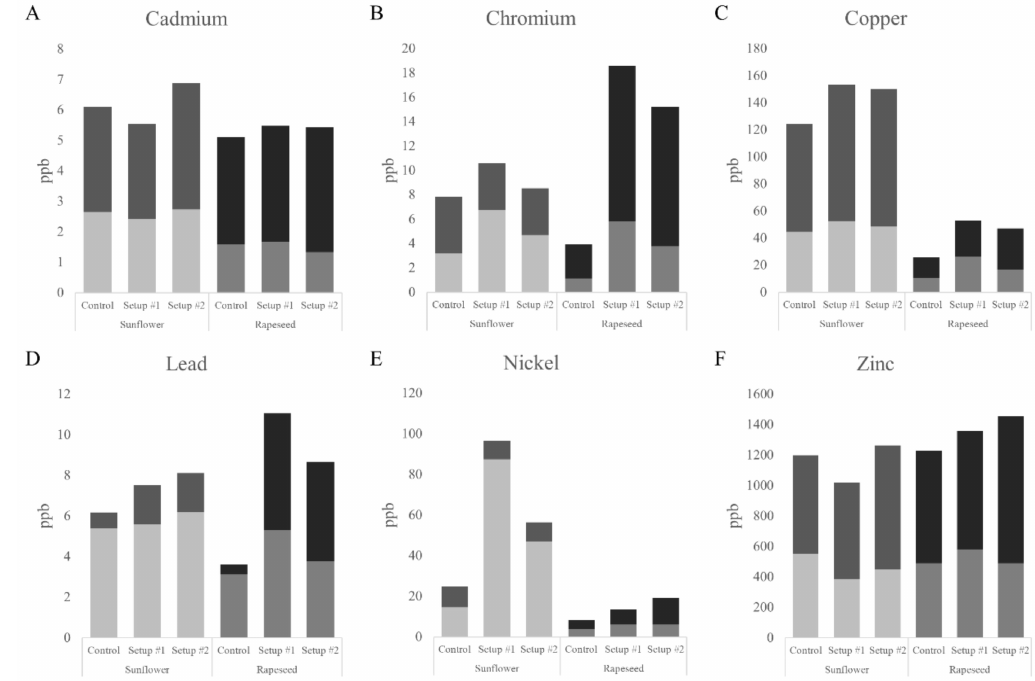
Figure 2. Microelement contents of the roots and shoots of sunflower and rapeseed (ppb): ( A ): cadmium, ( B ): chromium, ( C ): copper, ( D ): lead, ( E ): nickel, and ( F ): zinc. The bottom part of each bar represents the element content of the roots while the top part represents the